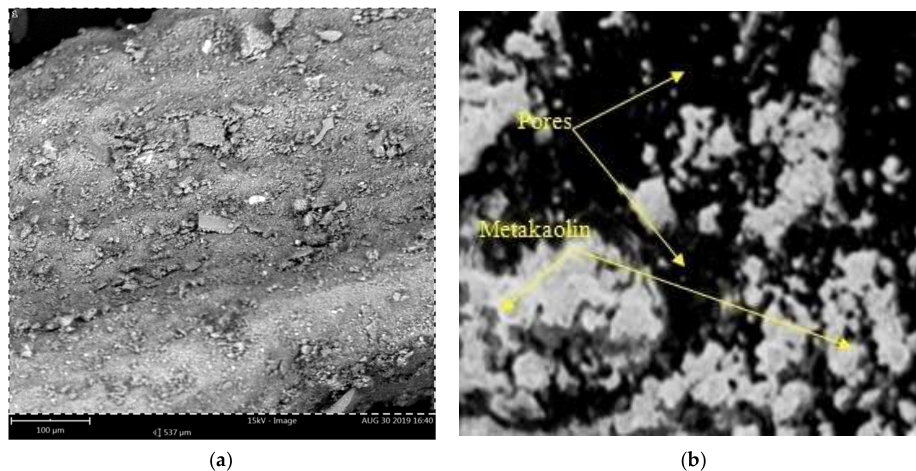
Figure 5. SEM ( a ) kaolin ( b ) Metakaolin.